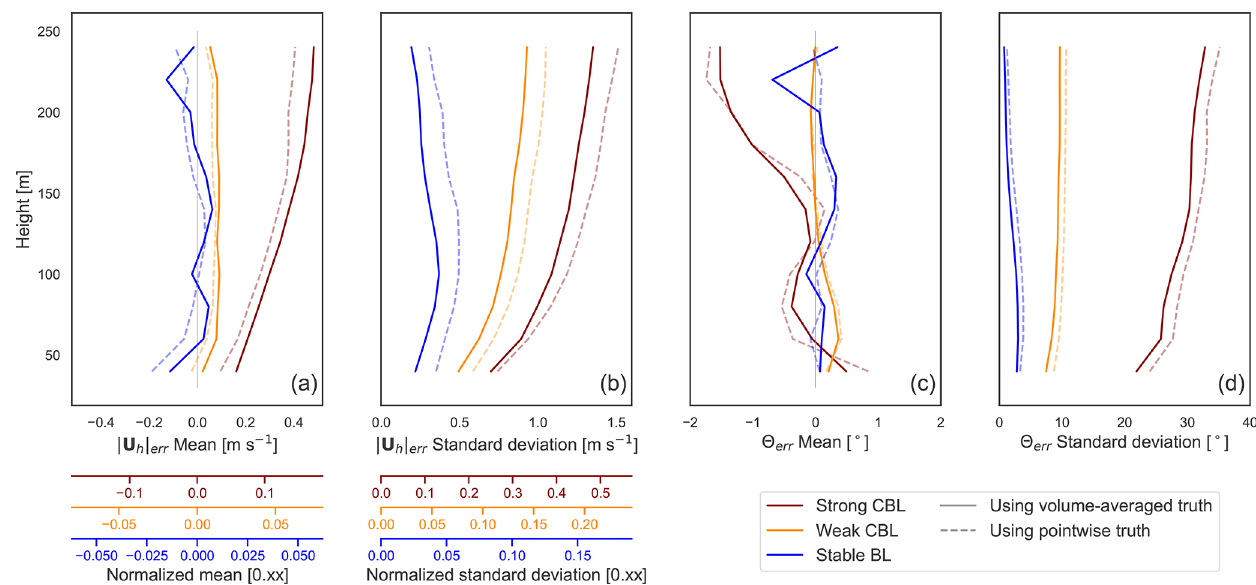
Figure 11. Mean and standard deviation of error in the 1Hz vector-averaged wind speed and wind direction. For wind speed, the primary axis gives absolute error, and colored secondary axes designate relative error with respect to 100m values for the respective LES